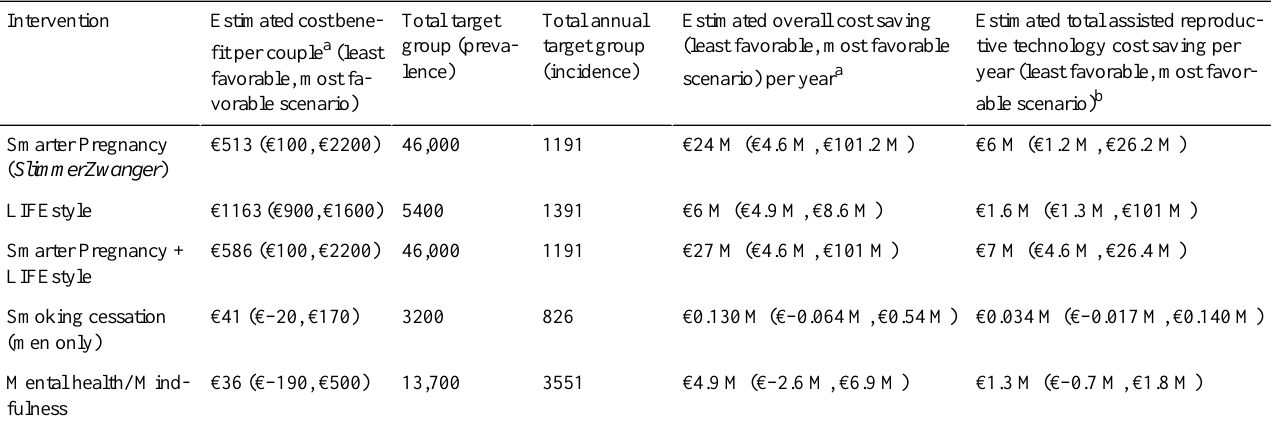
Table 4. Estimated cost savings per year of lifestyle interventions (business cases) on assisted reproductive technologies and reduction of pregnancy complications modeled for the Netherlands (an exchange rate of approximately €1=US $1.19 is applicable at the time of